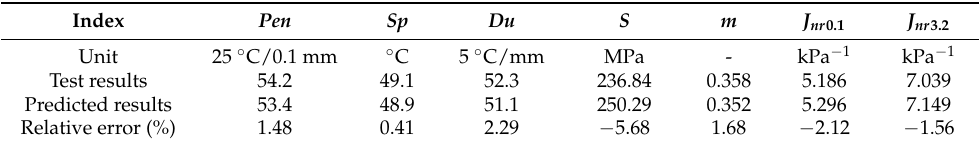
Table 8. Verification test results of CMA.